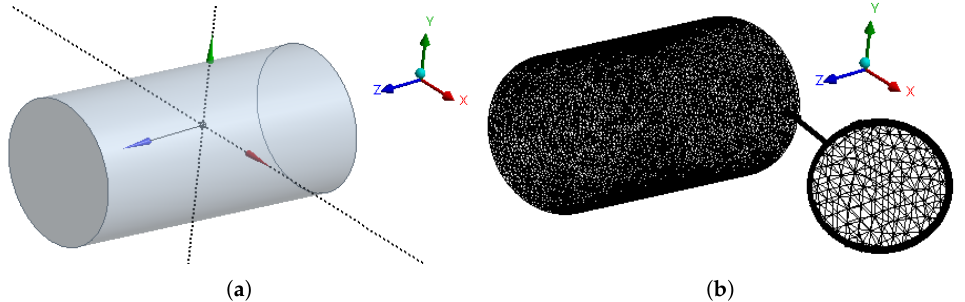
Figure 2. CAD and mesh of the simulation domain. ( a ) CAD Geometry. ( b ) Mesh of the